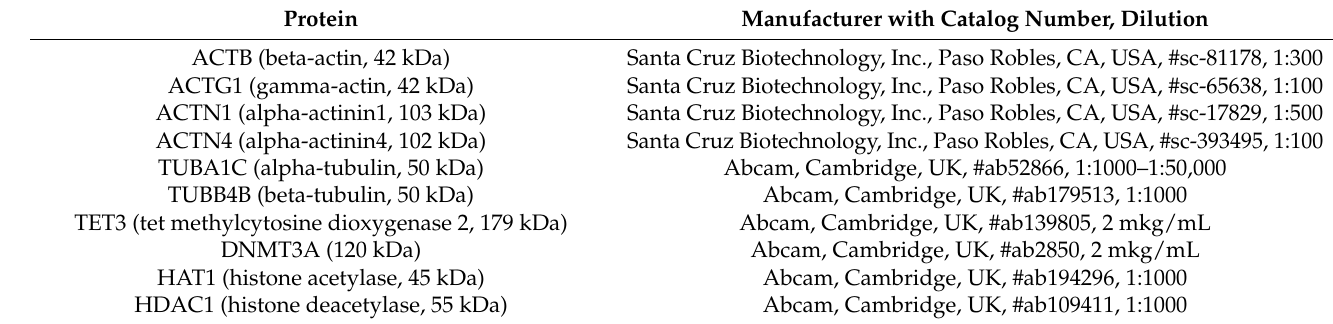
Table 1. Primary